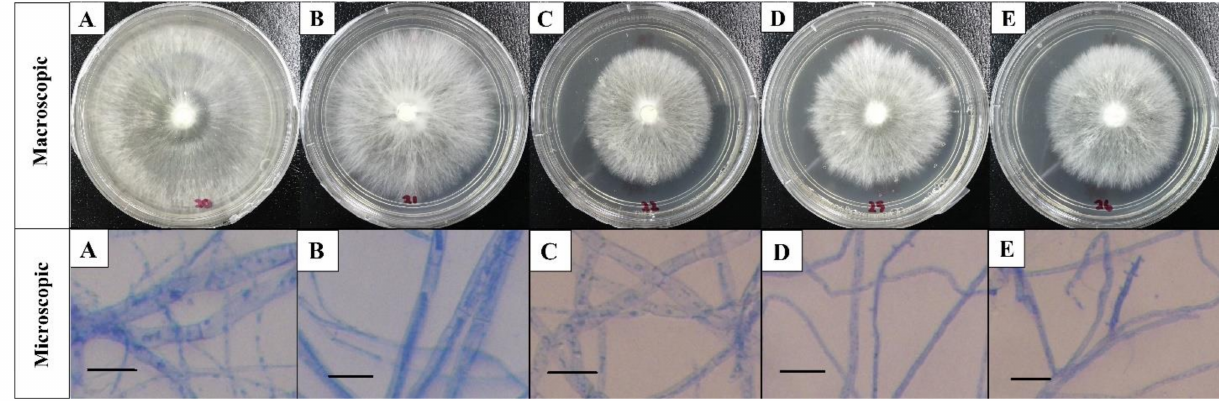
Figure 1. Macroscopic and microscopic view of white root rot pathogen isolates: ( A ) RL20, ( B ) RL21, ( C ) RL22, ( D ) RL25, ( E ) RL26 (Scale bar = 10 µ m; magnification: × 40).